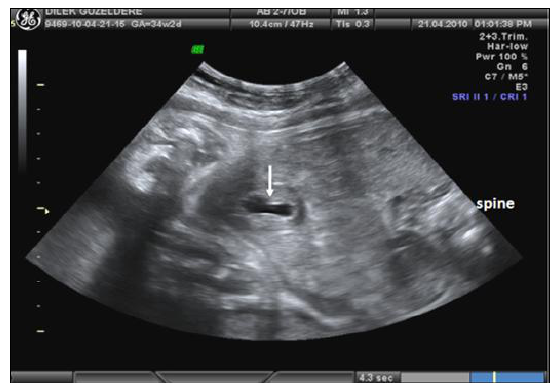
Figure 1A: A cystic thick walled pelvic mass (white arrow) was detected in the supra-pubic region instead of the